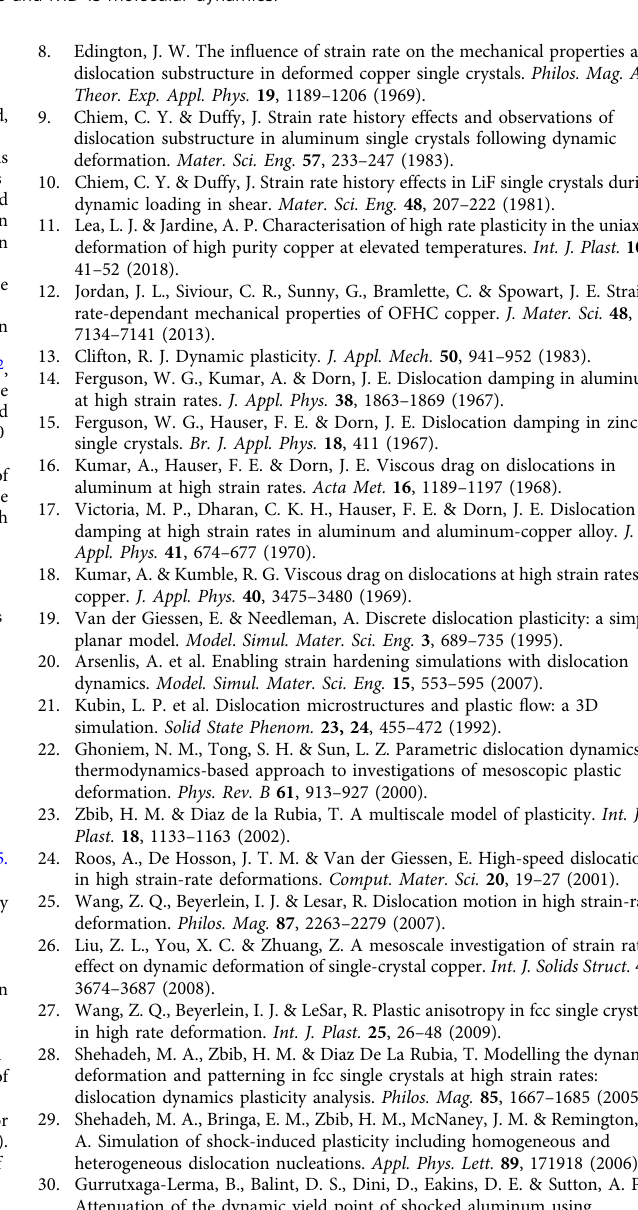
Fig. 8 Plastic strain during relaxation and dislocation mobility law in 3D-DDD simulations. a Plastic strain during relaxation for a simulation with an initial dislocation density of ρ 0 = 2.5 × 10 13 m − 2 in bulk copper. Insets show the initial dislocation con fi guration and relaxed con fi guration with dislocation junctions formed by reactions among the initially present dislocations. b Dislocation velocity versus resolved shear stress for an edge dislocation as predicted from MD simulations 47 , and the exponential dislocation mobility law shown in Eq. (9). Screw dislocation mobility is assumed equal to edge dislocation mobility. DDD is abbreviation of discrete dislocation dynamics and MD is molecular